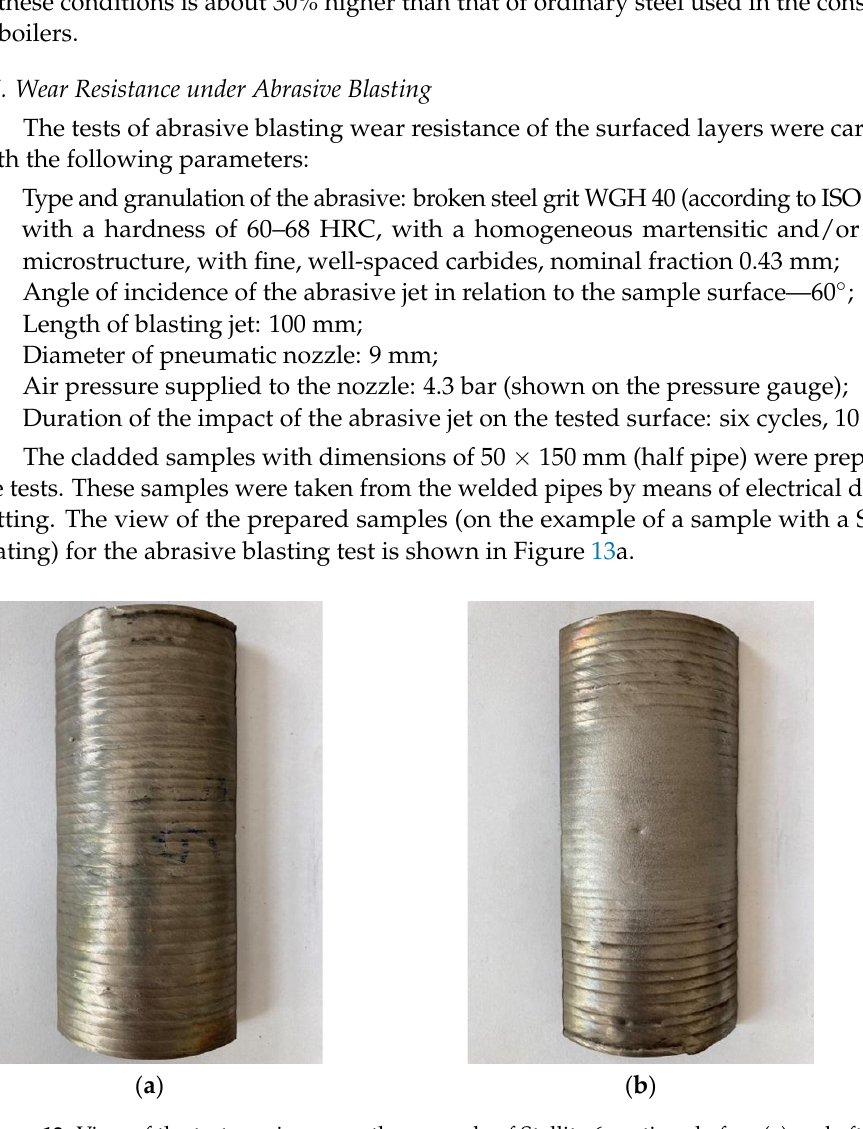
Table 6. Results of abrasive blasting wear test.